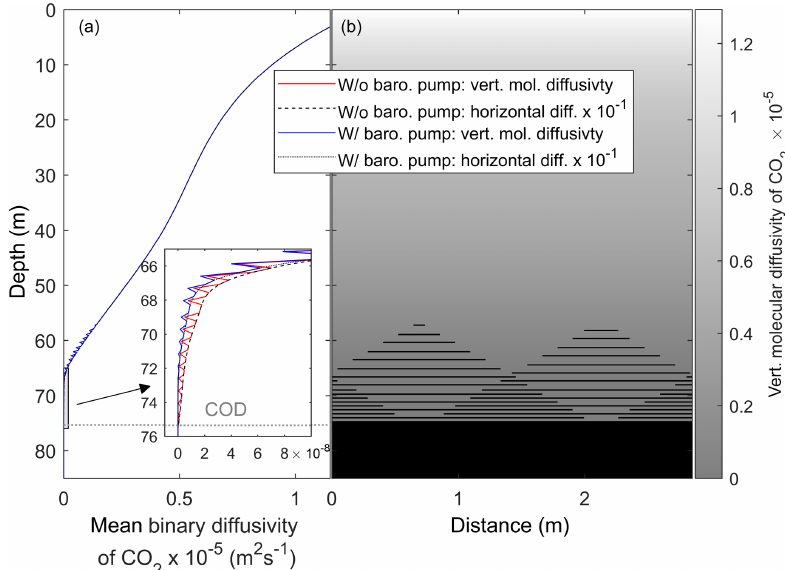
Figure 5. The CO 2 diffusivity profile at WAIS Divide. (a) Horizontally averaged, vertical and horizontal diffusivity in the model with and without barometric pumping. (b) Map of diffusivity in the 2-D model without barometric pumping. Only every third layer present in the model is shown here for